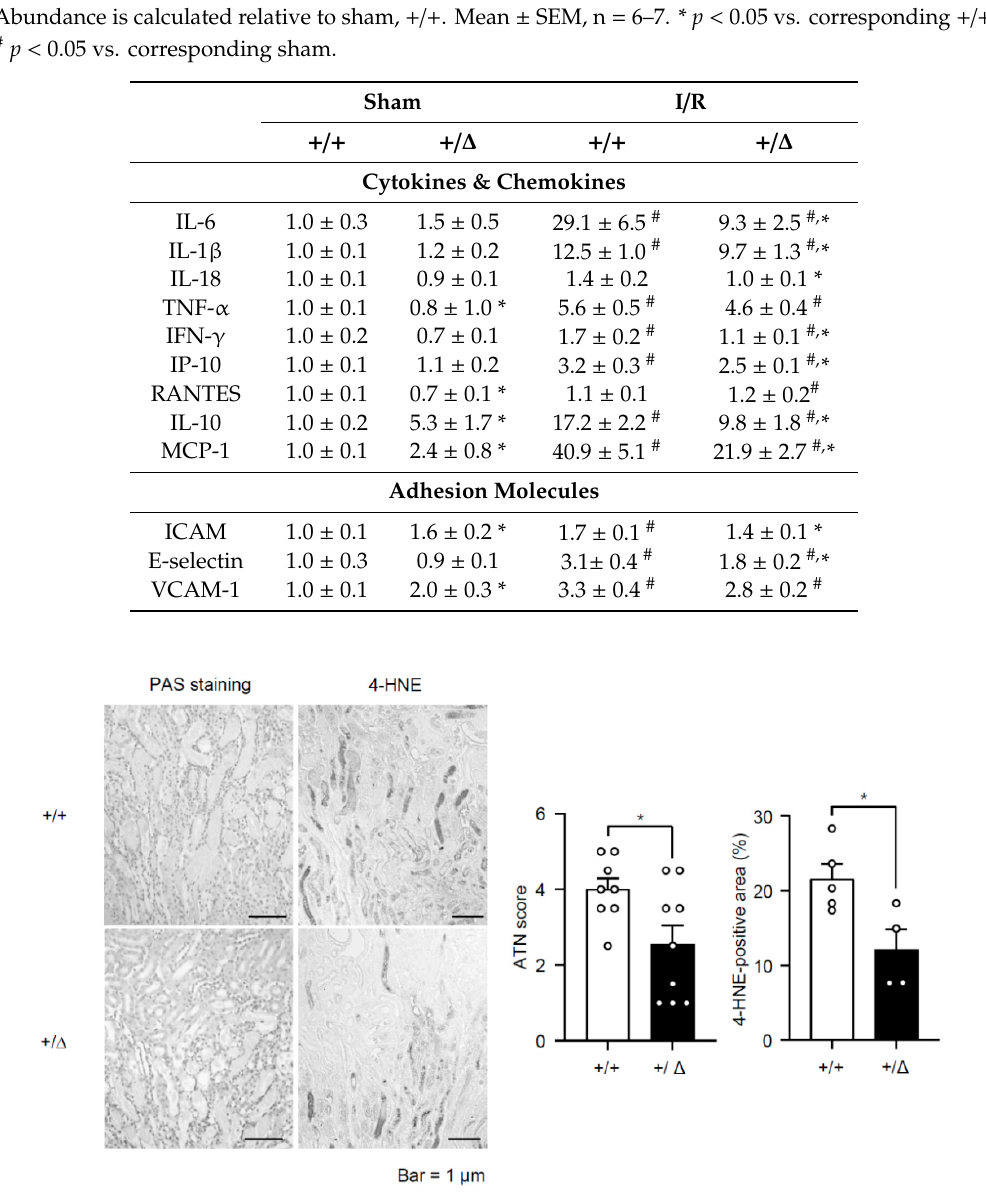
Figure 2. Renal tissues were obtained from TonEBP +/ ∆ ( +/ ∆ , filled bars) mice and their TonEBP +/+ littermates ( +/+ , open bars) after I / R treatment of kidneys. Tissue sections were stained with periodic acid-Schiff stain (PAS) and acute tubular necrosis (ATN) score was obtained. Tissue sections were also immunostained for 4-hydroxynonenal (4-HNE). 4-HNE positive area (%) was measured. Mean + SEM, * p < 0.05.